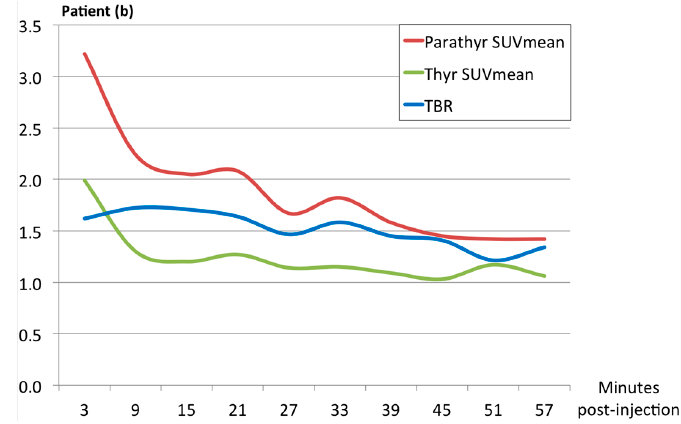
Figure 2. Region-of-interest based analysis of tracer-uptake in the first 60 min after tracer-injection in the parathyroid adenoma versus neighbouring tissue (thyroid) in patients ( a ) and ( b ). Target-to-background uptake value (TBR, blue) is the ratio between SUV mean (mean standardized uptake value) in the parathyroid adenoma and SUVmean in the adjacent thyroid tissue.